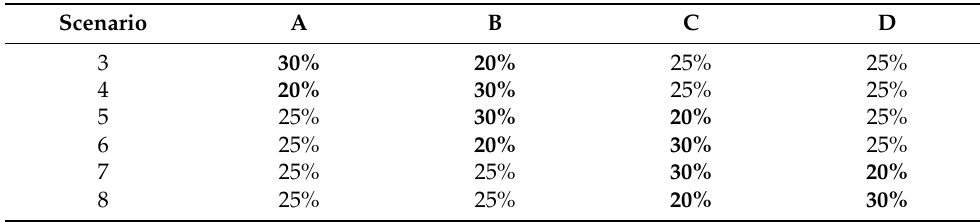
Table 9. Scenarios for composition disturbances in mol%. Changed compositions in each scenario are marked in